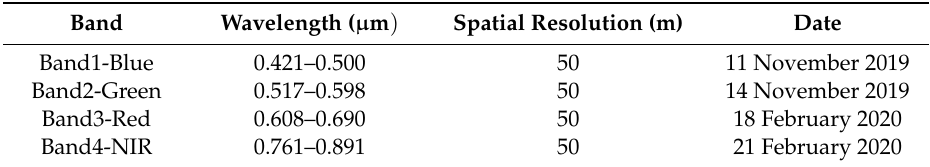
Table 3. The parameters of the Coastal Zone Imagery (CZI) sensor and information about the